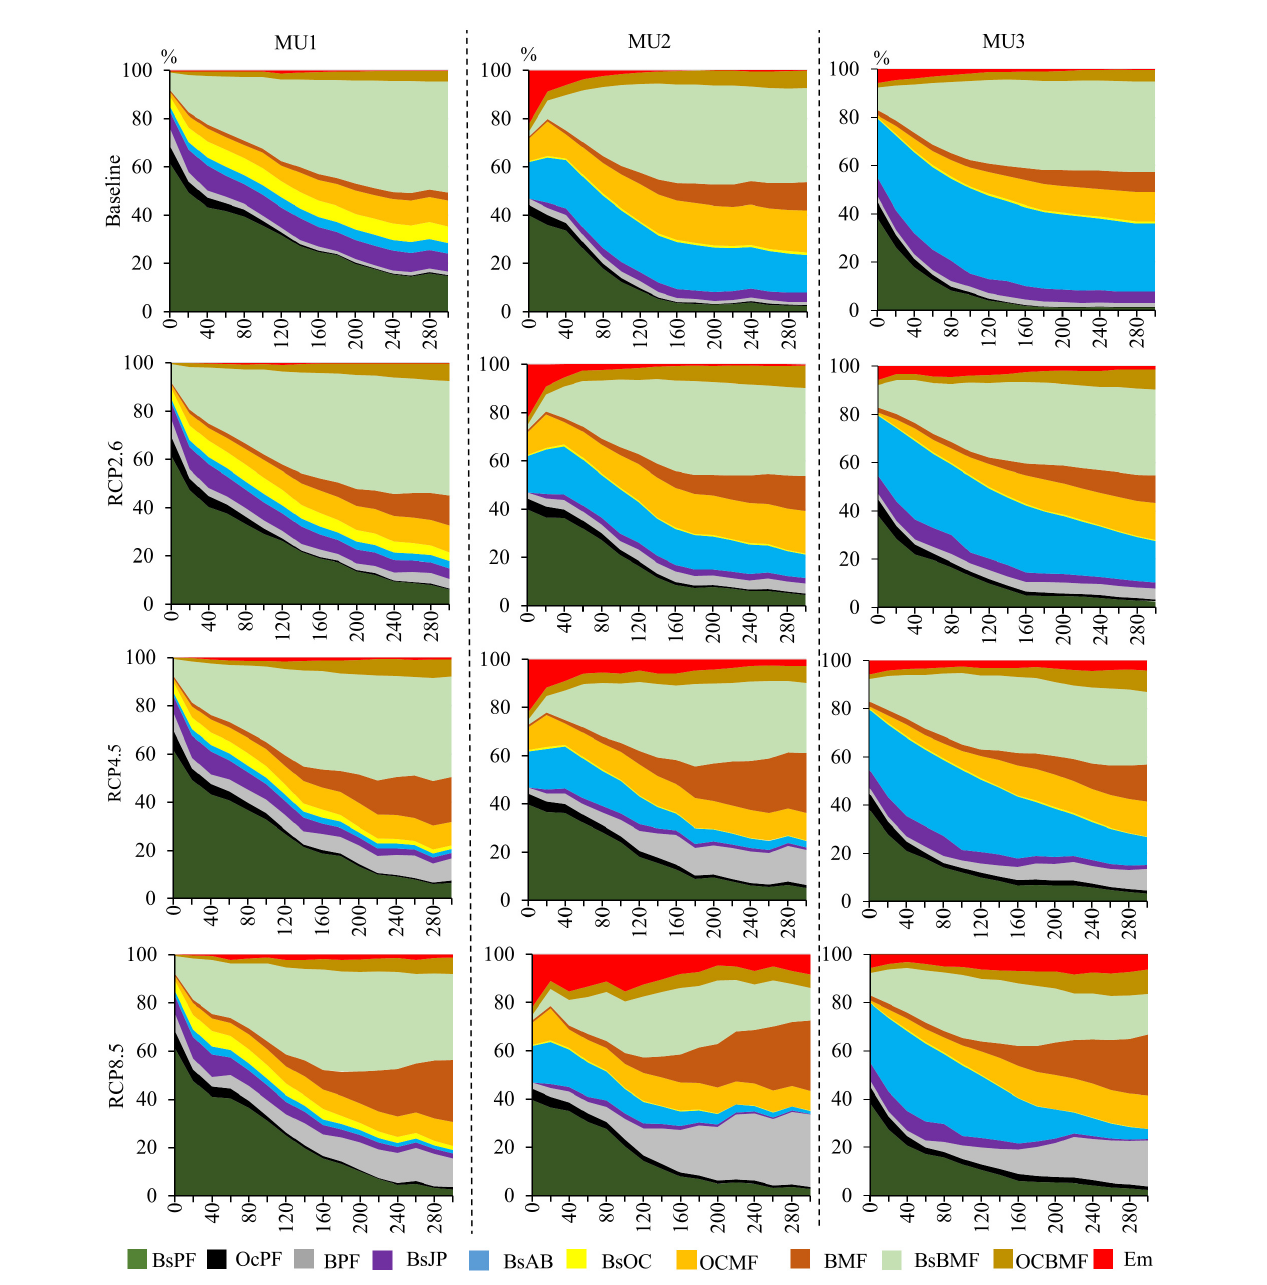
FIGURE8 The occupancy area (%) of forest type in the three MU under climate change and wildfires scenarios between 2010 (year 0) and 2310 (year 300) (BsPF, black spruce pure forests; OcPF, other coniferous pure forests; BPF, broadleaves pure forests; BsJP, black spruce and jack pine; BsAB, black spruce and balsam fir; BsOC, black spruce and other coniferous; OCMF, other coniferous mixed forests; BMF, broadleaves mixed forests; BsBMF, black spruce and broadleaves mixed forests; OCBMF, other coniferous and broadleaves mixed forests; Em, empty land which represents open forest